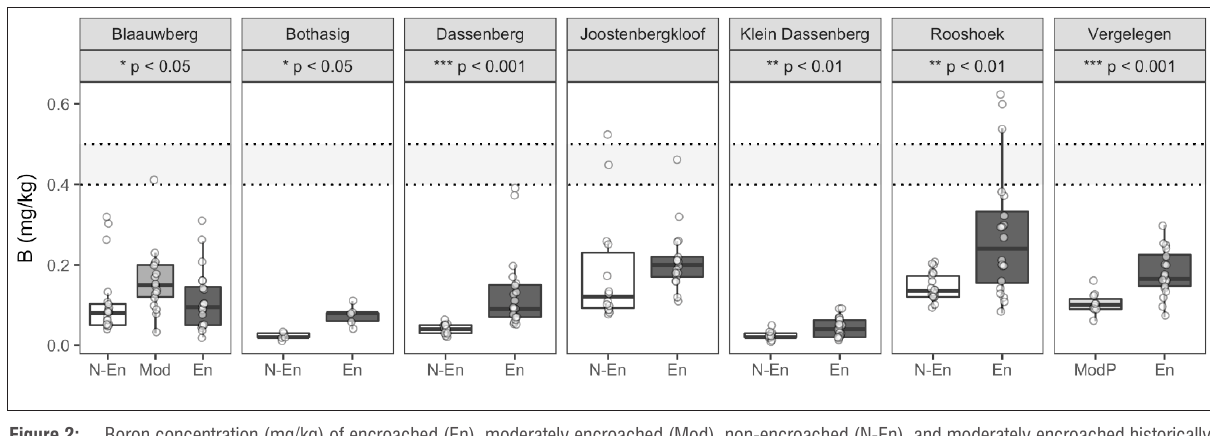
Figure 2: Boron concentration (mg/kg) of encroached (En), moderately encroached (Mod), non-encroached (N-En), and moderately encroached historically pine plantation (ModP) patches at the seven study sites. Horizontal grey bars indicate critical deficiency ranges (0.4–0.5 mg/kg). Fertilisation of agricultural lands at Vergelegen (N-En and ModAg) greatly increased B concentrations. These fertilised sites are consequently excluded from the